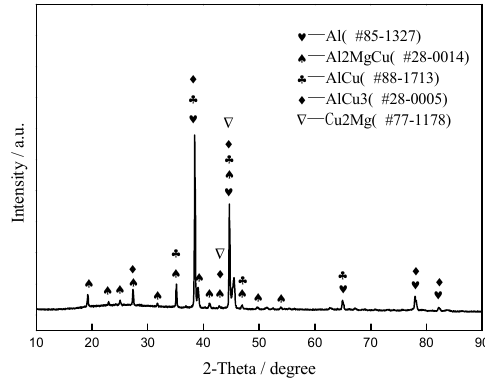
Figure 8. X-ray diffraction analysis curve of the foil-like brazing filler metal.